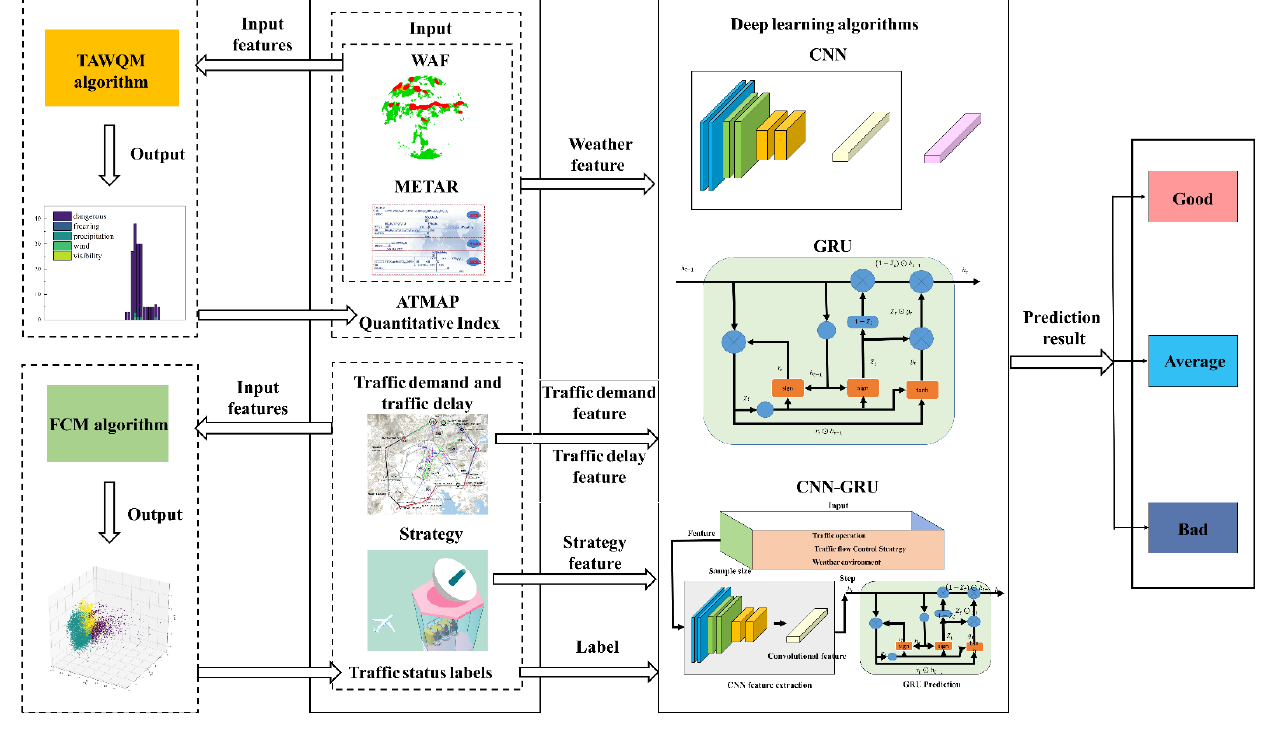
Figure 1. Framework of TSPM-W.